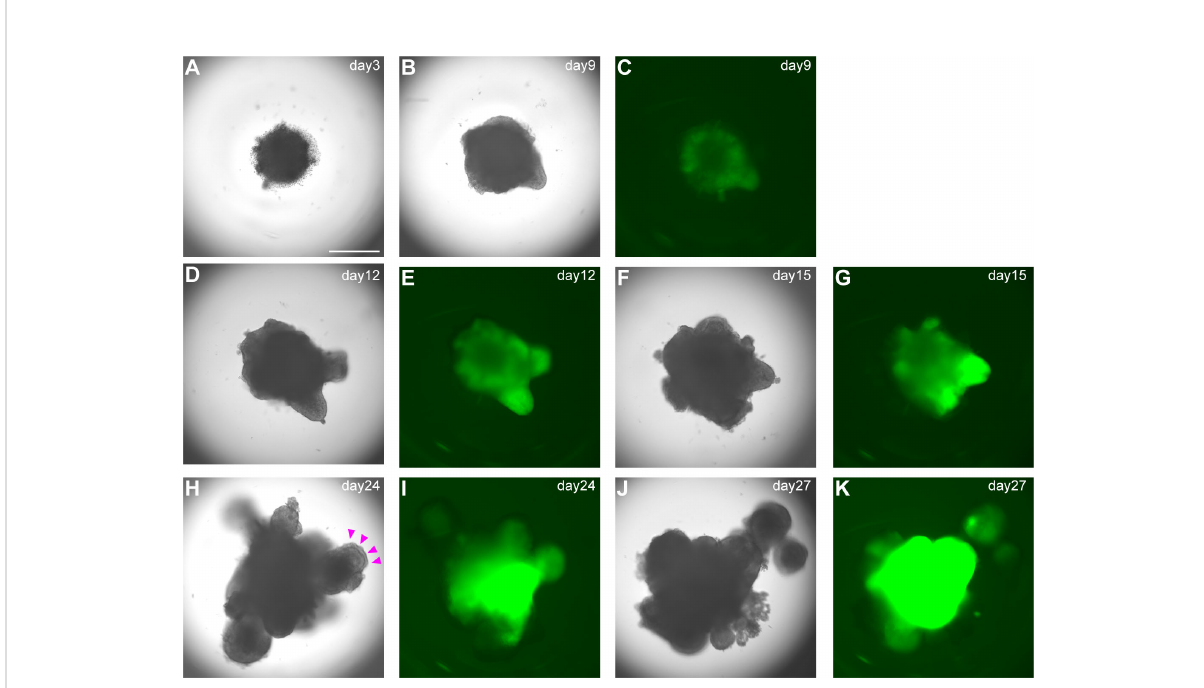
FIGURE 3 Differentiation into early pituitary primordium in SFEBq culture. (A – K) Bright- fi eld and EGFP fl uorescence microscopy views of aggregates in SFEBq culture. We used the KhES-1_Rx::Venus (VA22-N37) cell line, carrying Venus knocked into the Rx locus (13). RX::Venus-expressing hypothalamic tissues are visible from day 9. On day 24, oral ectoderm-like tissue appears on the surface of the aggregate ( H , magenta arrowheads). This feature can be clearly identi fi ed in bright- fi eld. Scale bar: 500 m